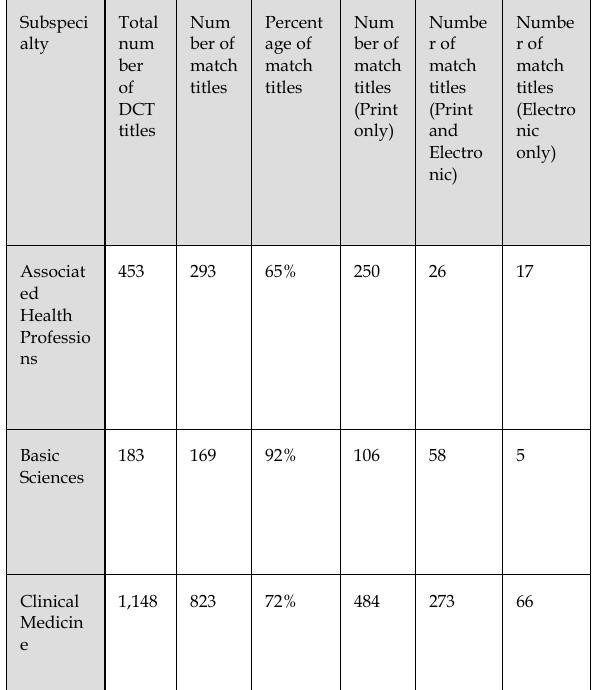
Table 3 Percentage of match of the subspecialties to